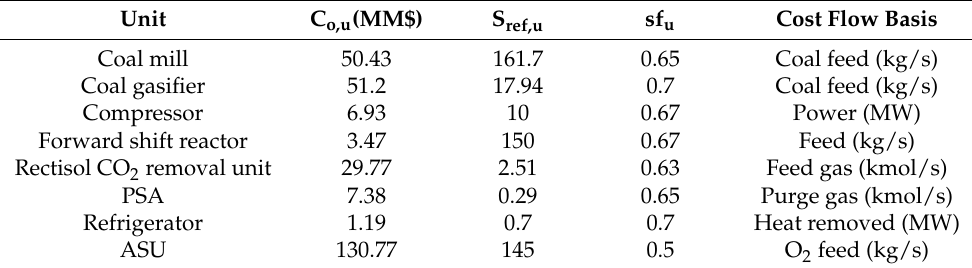
Table 2. Cost parameters in the CtH system [25].